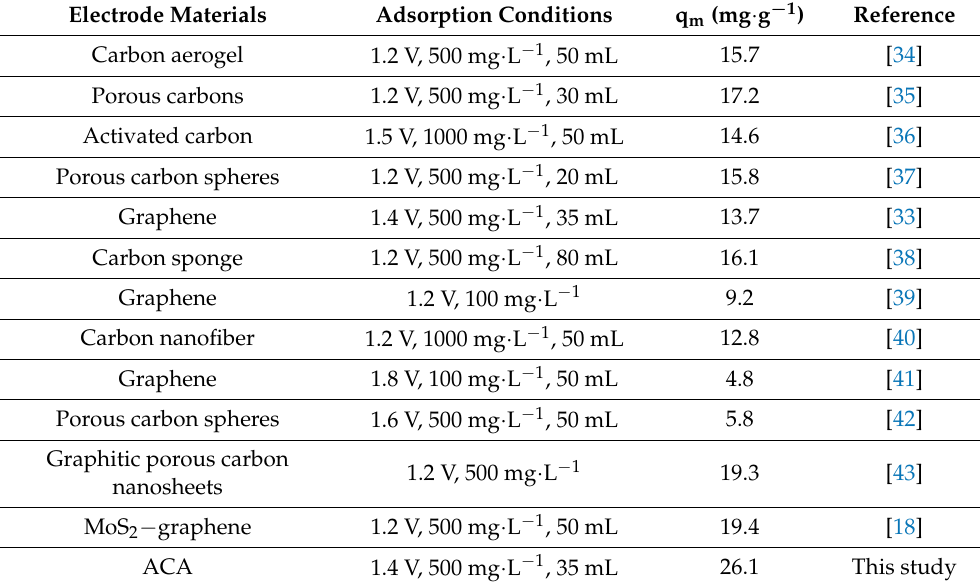
Table 1. Comparison of NaCl adsorption capability of ACA electrode and other electrode materials.